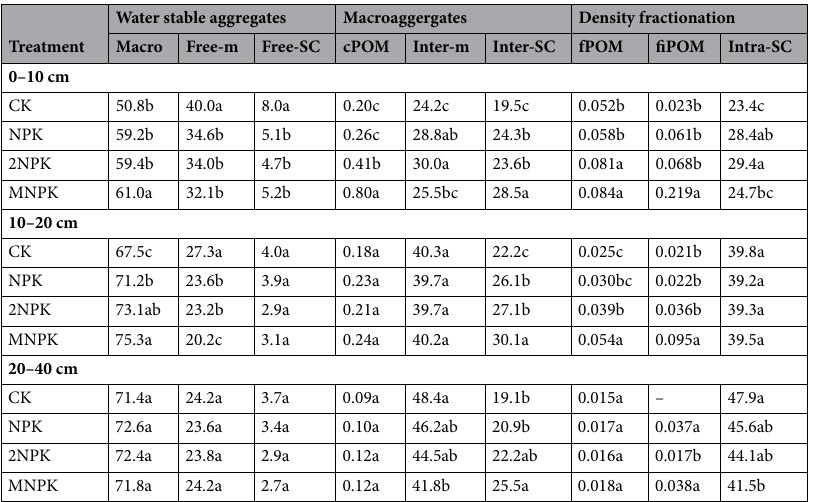
Table 1. Masses of water-stable aggregates and macroaggregate fractions to 40 cm deep in the control treatment (CK), chemical fertilizer treatments (NPK and 2NPK), and combined manure and chemical fertilizer treatment (MNPK) (unit = %). Each value is the mean of three replicates. Different letters within the same column indicate the least significant difference values at the 0.05 level (LSD0.05) for the different treatments at the different depths. Macro, free-m, and free-SC are macroaggregates (> 250 µm diameter), microaggregates (53–250 µm diameter), and silt plus clay (< 53 µm diameter), respectively. cPOM, inter-m, and inter-SC are coarse particulate organic matter (POM), microaggregates in macroaggregates, and silt–clay in macroaggregates, respectively. fPOM, fiPOM, and intra-SC are fine POM, fine intra-POM, and intra-silt– clay in inter-m, respectively. Inter-m is the sum of fPOM, fiPOM, and intra-SC. fiPOM was not detected at 20–40 cm